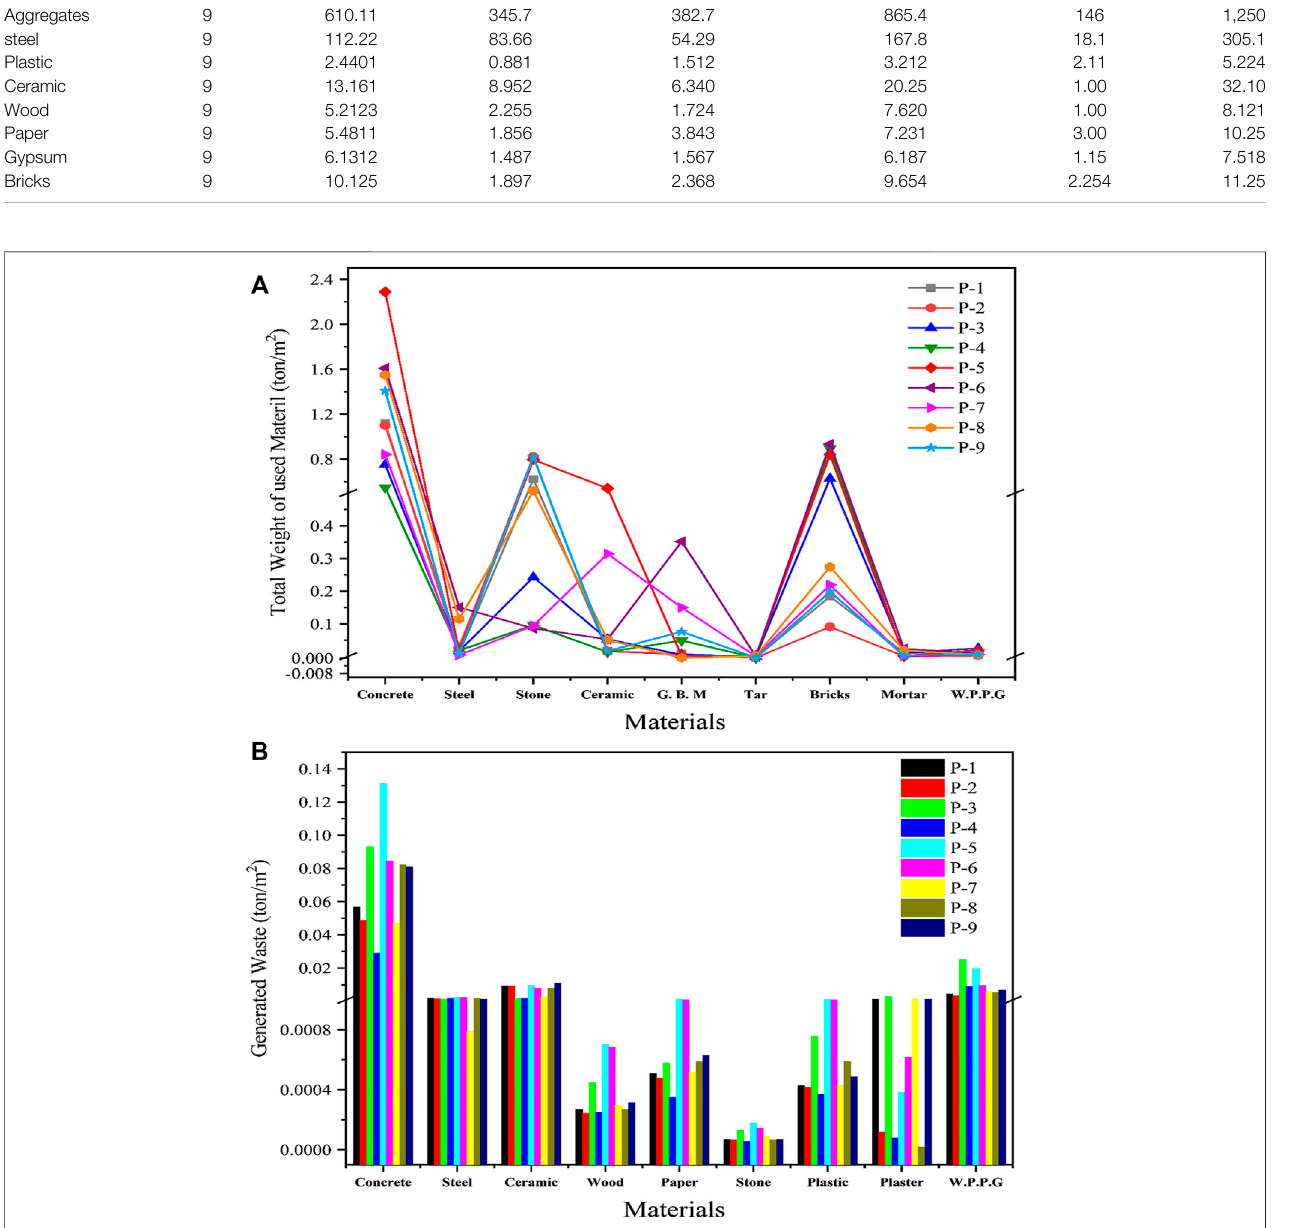
FIGURE 5 | Weight of selected projects. (A) Total used weight. (B) Total generated weight.